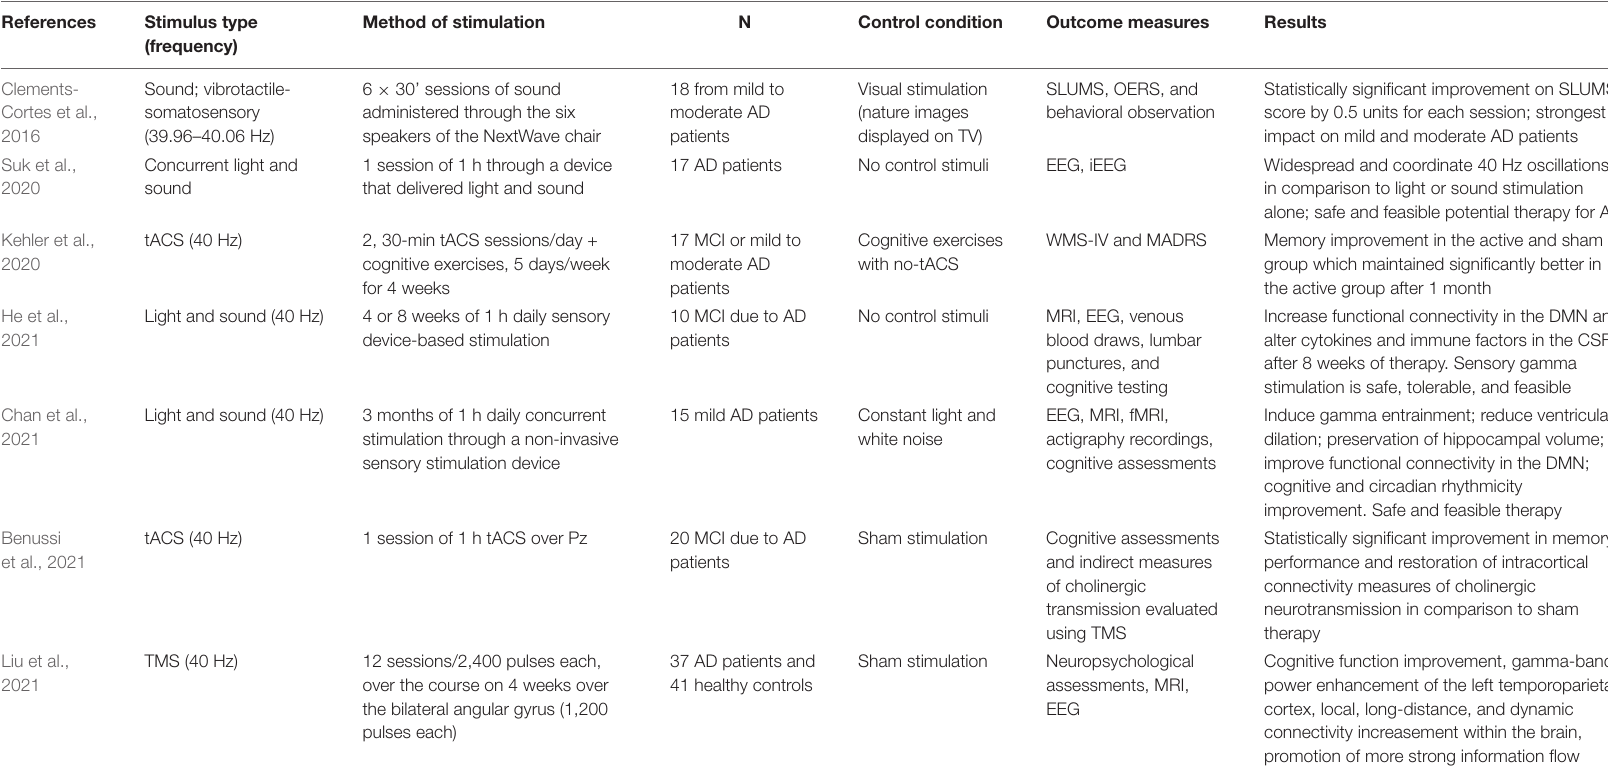
TABLE 1 | Summary of clinical studies that applied gamma frequency brain stimulation to Alzheimer’s Disease (AD)